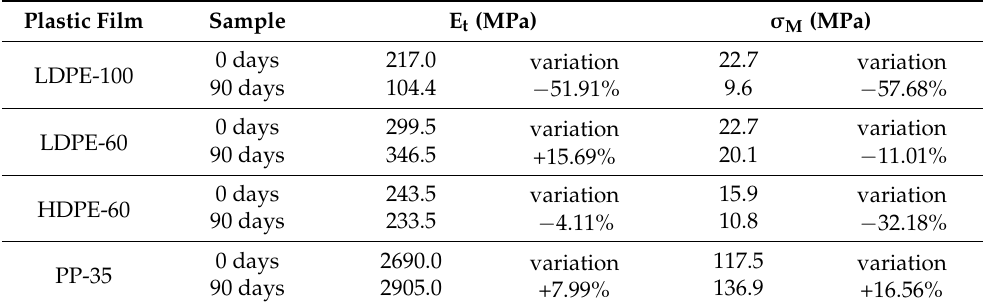
Table 7. 0 days and 90 days exposure comparisons: longitudinal and transversal average data for 0 days